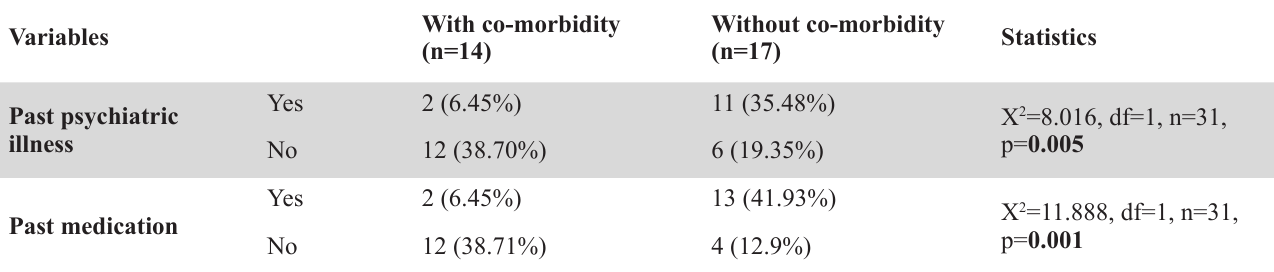
Table 4. Clinical Comparison between alcohol dependent patients with and without comorbidity